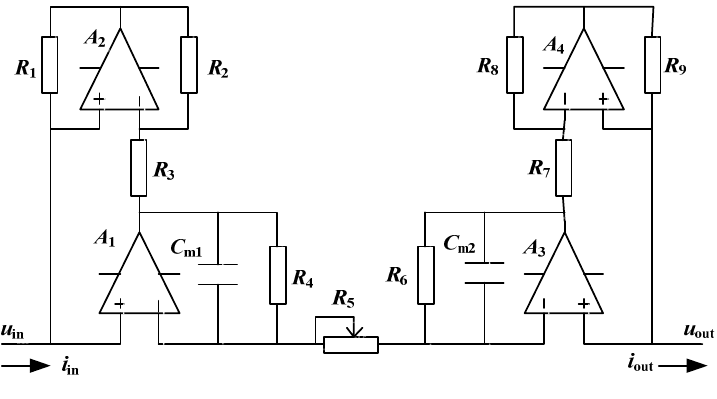
Figure 3. Circuit of the improved simulated inductor.